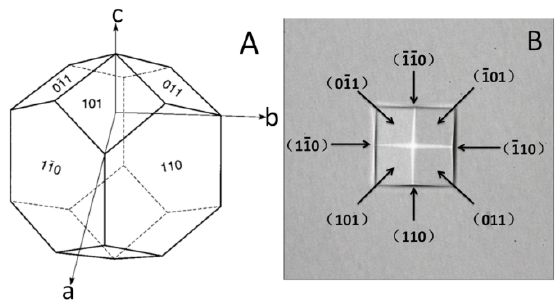
Figure 2. Illustration of the normal growth habit of tetragonal lysozyme crystals and a lysozyme crystal observed. ( A ) Illustration of the normal growth habit of tetragonal lysozyme crystals; ( B ) a lysozyme crystal observed.